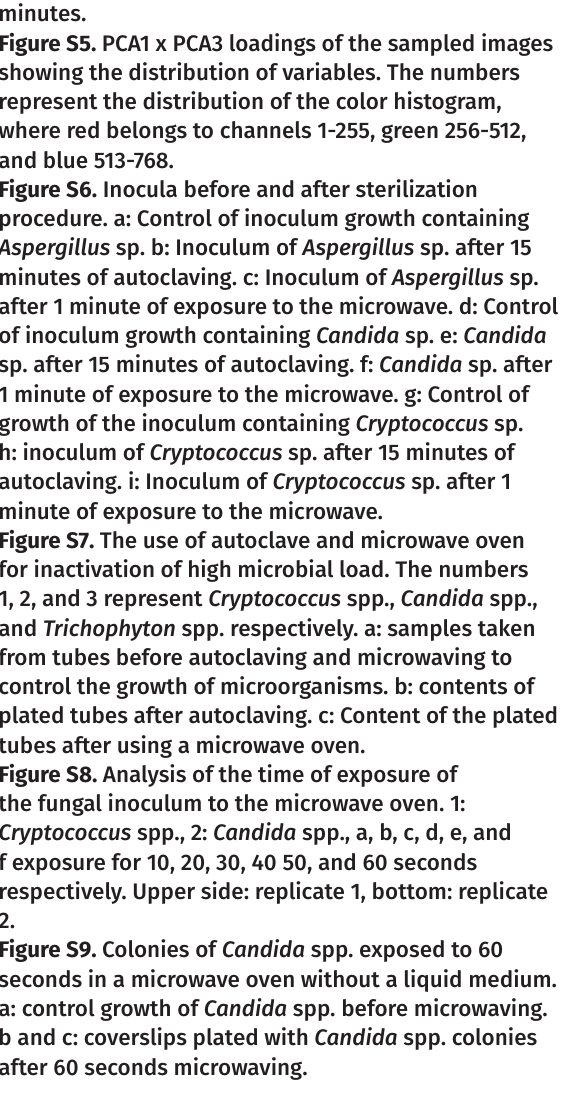
30 minutes. Autoclave40m: autoclaved agar for 40 minutes. Figure S5. PCA1 x PCA3 loadings of the sampled images showing the distribution of variables. The numbers represent the distribution of the color histogram, where red belongs to channels 1-255, green 256-512, and blue 513-768. Figure S6. Inocula before and after sterilization procedure. a: Control of inoculum growth containing Aspergillus sp. b: Inoculum of Aspergillus sp. after 15 minutes of autoclaving. c: Inoculum of Aspergillus sp. after 1 minute of exposure to the microwave. d: Control of inoculum growth containing Candida sp. e: Candida sp. after 15 minutes of autoclaving. f: Candida sp. after 1 minute of exposure to the microwave. g: Control of growth of the inoculum containing Cryptococcus sp. h: inoculum of Cryptococcus sp. after 15 minutes of autoclaving. i: Inoculum of Cryptococcus sp. after 1 minute of exposure to the microwave. Figure S7. The use of autoclave and microwave oven for inactivation of high microbial load. The numbers 1, 2, and 3 represent Cryptococcus spp., Candida spp., and Trichophyton spp. respectively. a: samples taken from tubes before autoclaving and microwaving to control the growth of microorganisms. b: contents of plated tubes after autoclaving. c: Content of the plated tubes after using a microwave oven. Figure S8. Analysis of the time of exposure of the fungal inoculum to the microwave oven. 1: Cryptococcus spp., 2: Candida spp., a, b, c, d, e, and f exposure for 10, 20, 30, 40 50, and 60 seconds respectively. Upper side: replicate 1, bottom: replicate Figure S9. Colonies of Candida spp. exposed to 60 seconds in a microwave oven without a liquid medium. a: control growth of Candida spp. before microwaving. b and c: coverslips plated with Candida spp. colonies after 60 seconds